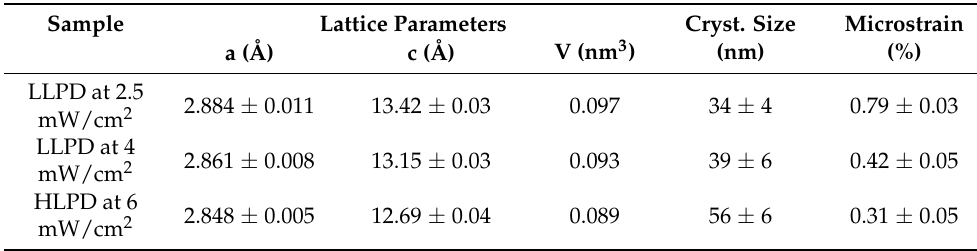
Table 2. The lattice parameters, average crystal size, volume of the unit cell, and microstrain of the 211 MAX phase calculated from the results of MAUD